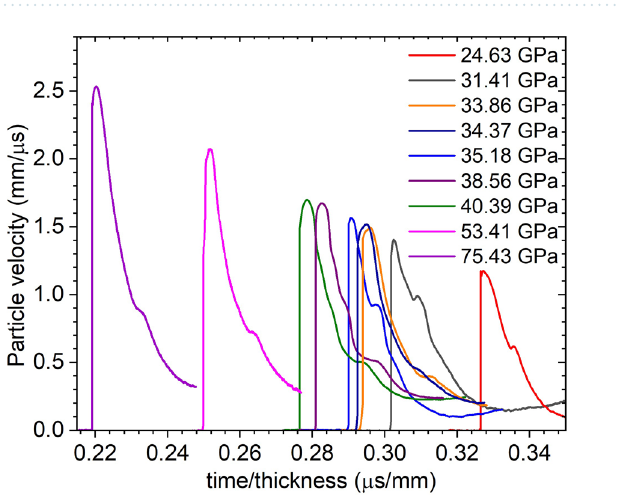
Figure 10. Measured apparent PDV velocities (in black) and pyrometry data centered at 1425 nm (in red) for four shots. Green curves indicate a 1225 nm measurement available in all but one experiment. Black lines show a scaled version of the velocimetry measurement for comparison. Time zero corresponds to shock breakout time at Sm/LiF interface.